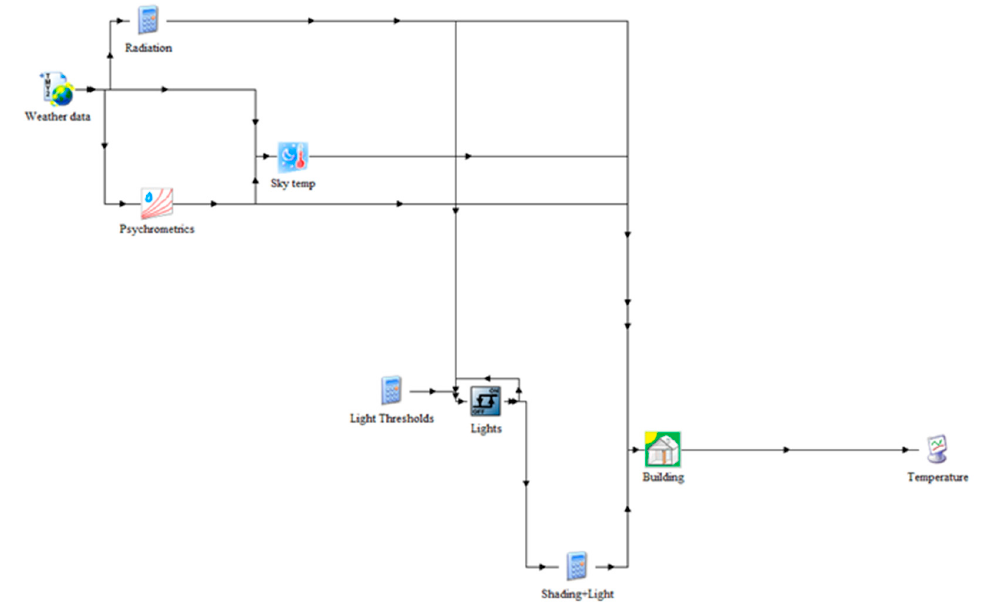
Figure 2. The building model in TRNSYS.